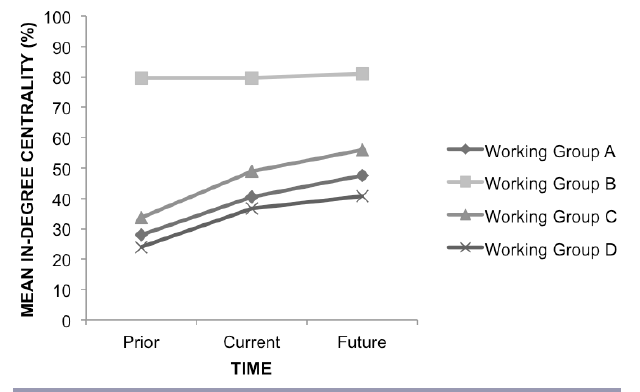
Fig. 4 . Working group centrality over time. Centrality can describe the most important, powerful, and/or prominent actors located within a network.